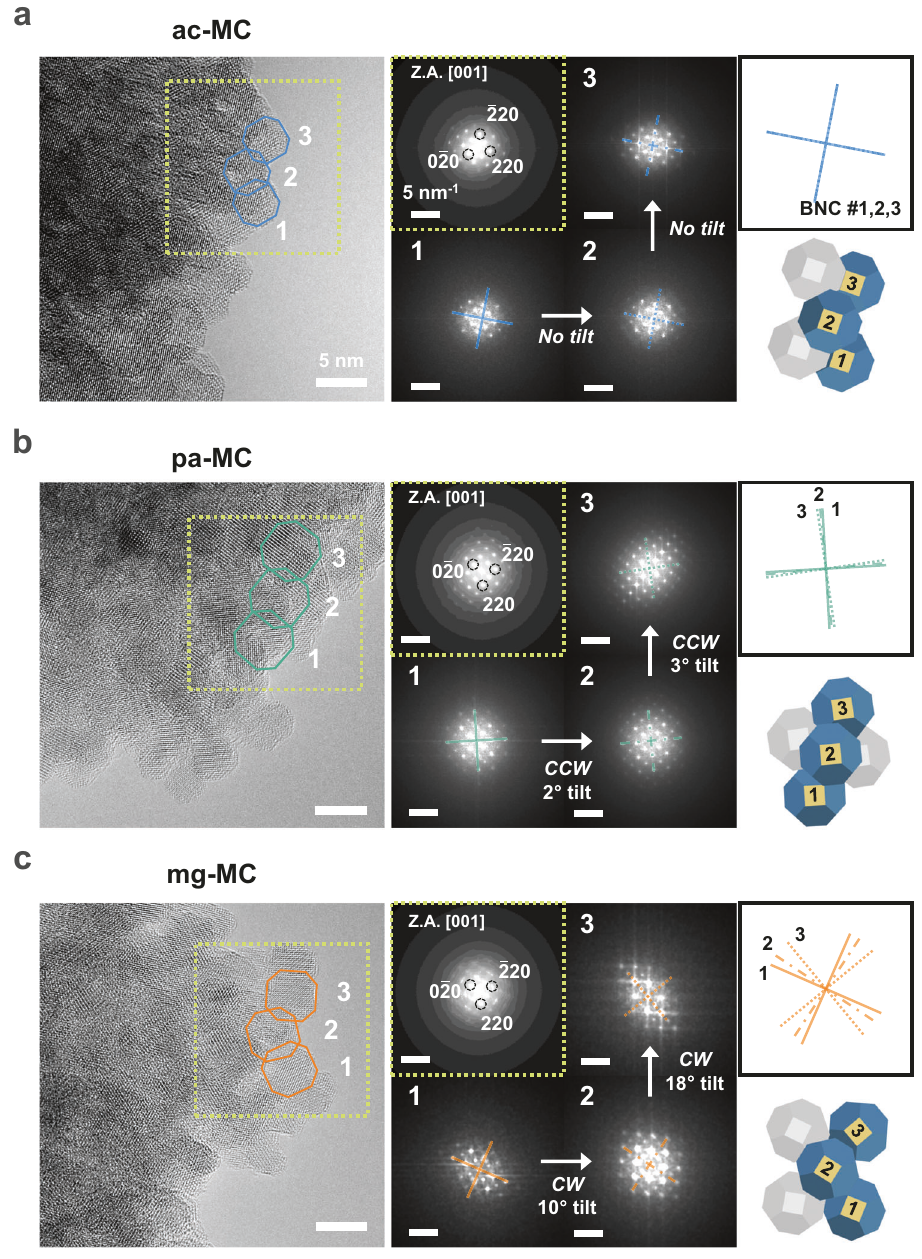
Fig. 5 Local BNC alignment within a mesocrystal. a – c HR-TEM (left) images and FFT patterns (right) of ac-MCs with the ordered state ( a ), pa-MC with the intermediate state ( b ), and mg-MC with the disordered state ( c ). The yellow dotted boxes indicate the region with the [001] zone axis. Three FFT patterns were acquired from each BNC having the same numbering in the HR-TEM images. The tilt angle between adjacent BNCs was measured using the auxiliary crosses connecting {110} planes in each FFT pattern; solid lines: BNC #1, dash – single dotted line: BNC #2, and dotted line: BNC #3. Overlaid crosses and schematics were reconstructed based on each FFT pattern as a visual